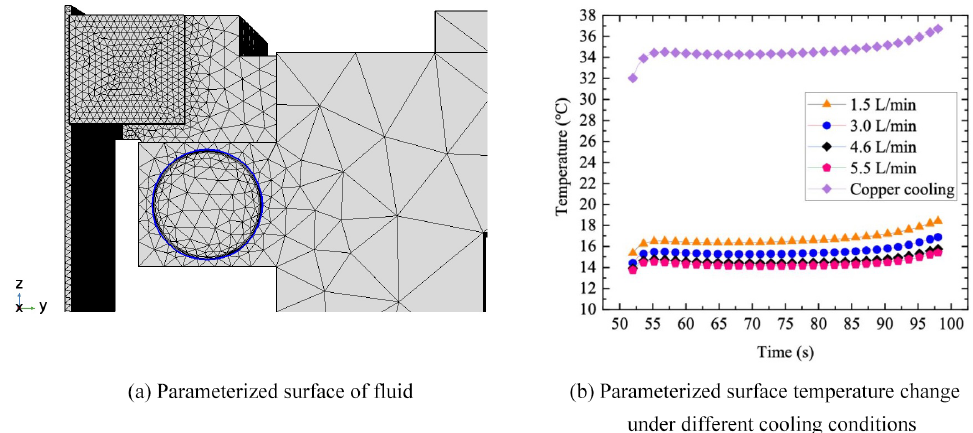
Figure 11. The parameterized surface of the fluid. (a) Parameterized surface of fluid. (b) Parameterized surface temperature change under different cooling conditions.